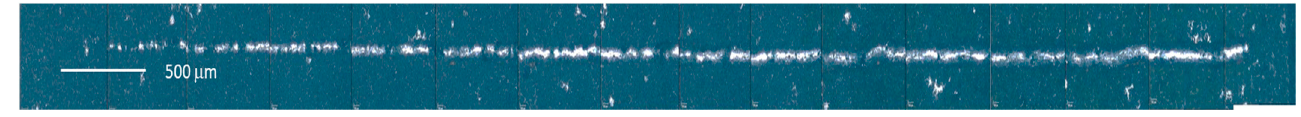
Figure 4. Scratch track of WC-Co-Cr coatings.